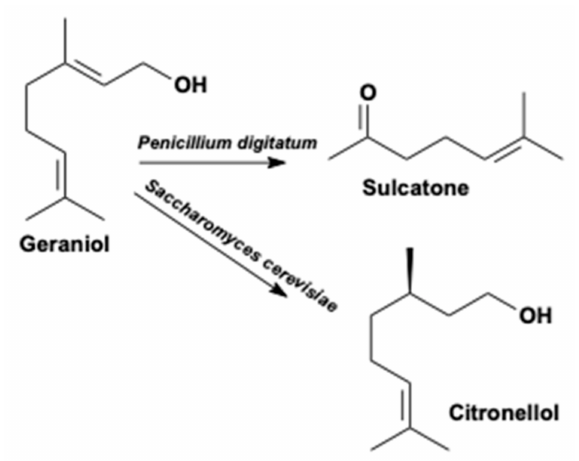
Figure 1. Biotransformation of geraniol into sulcatone and citronellol, two new biopesticide compounds, by Penicillium digitatum and Saccharomyces cerevisiae , respectively